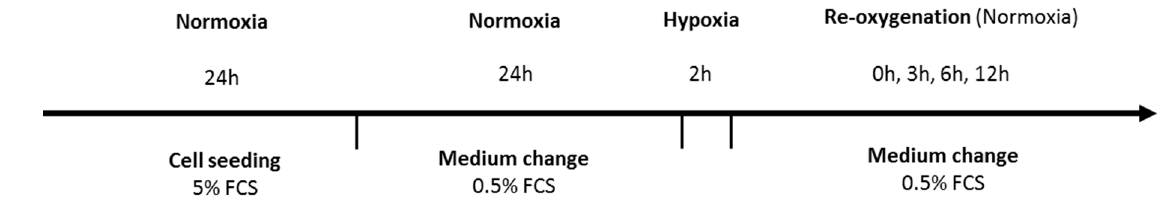
Figure 5. Schematic illustration of the in vitro hypoxia model used in this study.